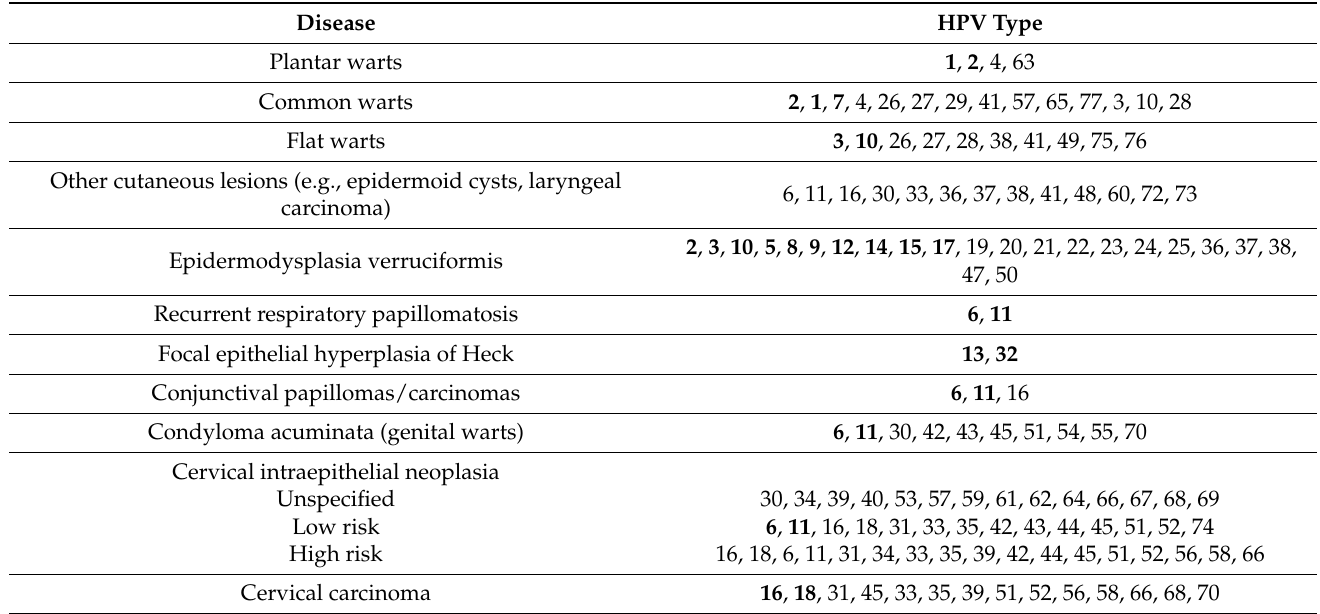
Table 1. HPV type and disease